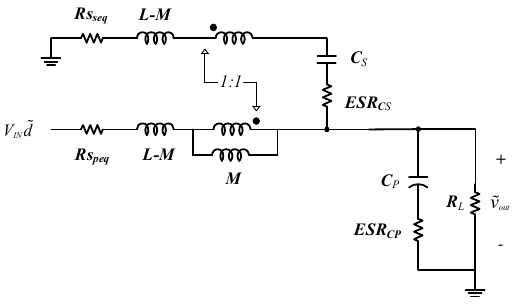
Figure 22. The small-signal model of a stacked buck converter in the form of coupled inductance within the boundary-limited interval.